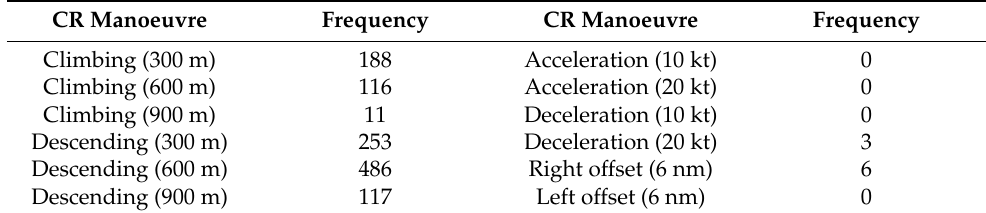
Table 8. Distribution of the CR manoeuvres performed by the